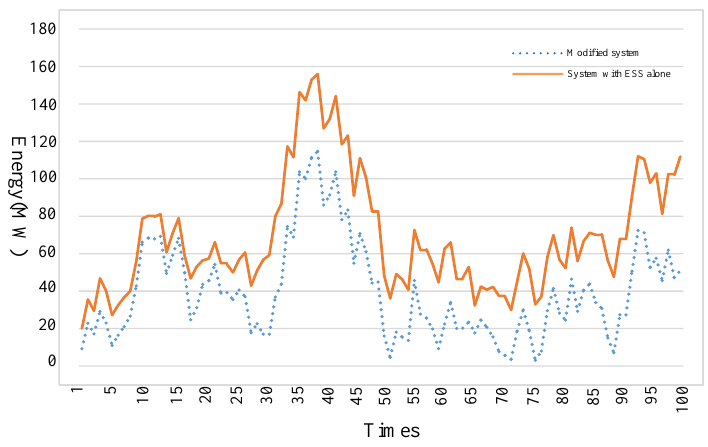
Figure 20. A comparison results of energy storage power between the proposed modified system and the energy storage system.